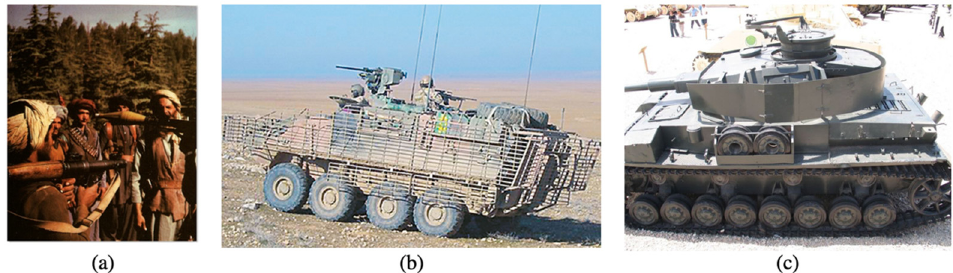
Figure 1. In order to counter the threat associated with the RPG-7 weapon system ( a ) many countries have equipped their vehicles with a cage armour system ( b ). The working principle is based on creating a short-circuit in the electrical circuit of the detonation chain and not, as often wrongly assumed, on increasing the standoff distance like the ‘bazooka plates’ as used in World War II ( c ). Source pictures: Wikipedia.org, all pictures released under GFDL or CC-BY 2.5.